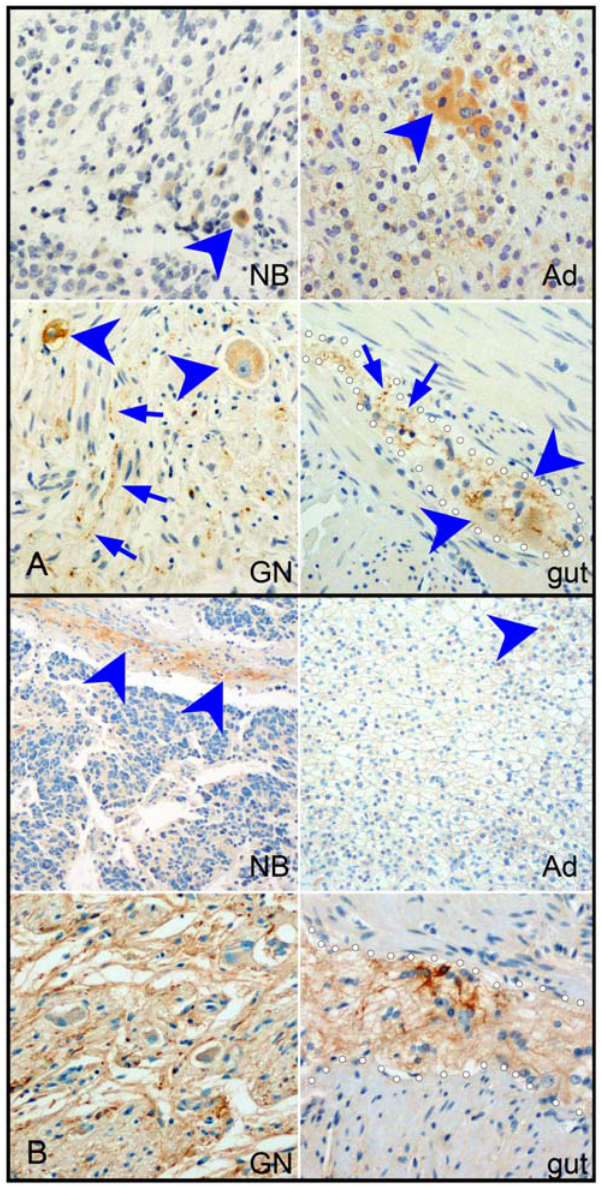
Figure 2. Enteric NC markers CGRP (A), and GFAP (B) were expressed more strongly in GN than NB. Antibodies to CGRP labeled rare cells (blue arrowheads) in NB and adrenal medulla (Ad), while labeling neurons (blue arrowheads) and processes (blue arrows) throughout both GNs and enteric ganglia (gut). Antibodies to GFAP labeled stromal cords in NB and rare adrenal medullary cells (blue arrowheads). In contrast, labeling was intense and widespread in GN and in ganglia of the gut (outlines by dotted white